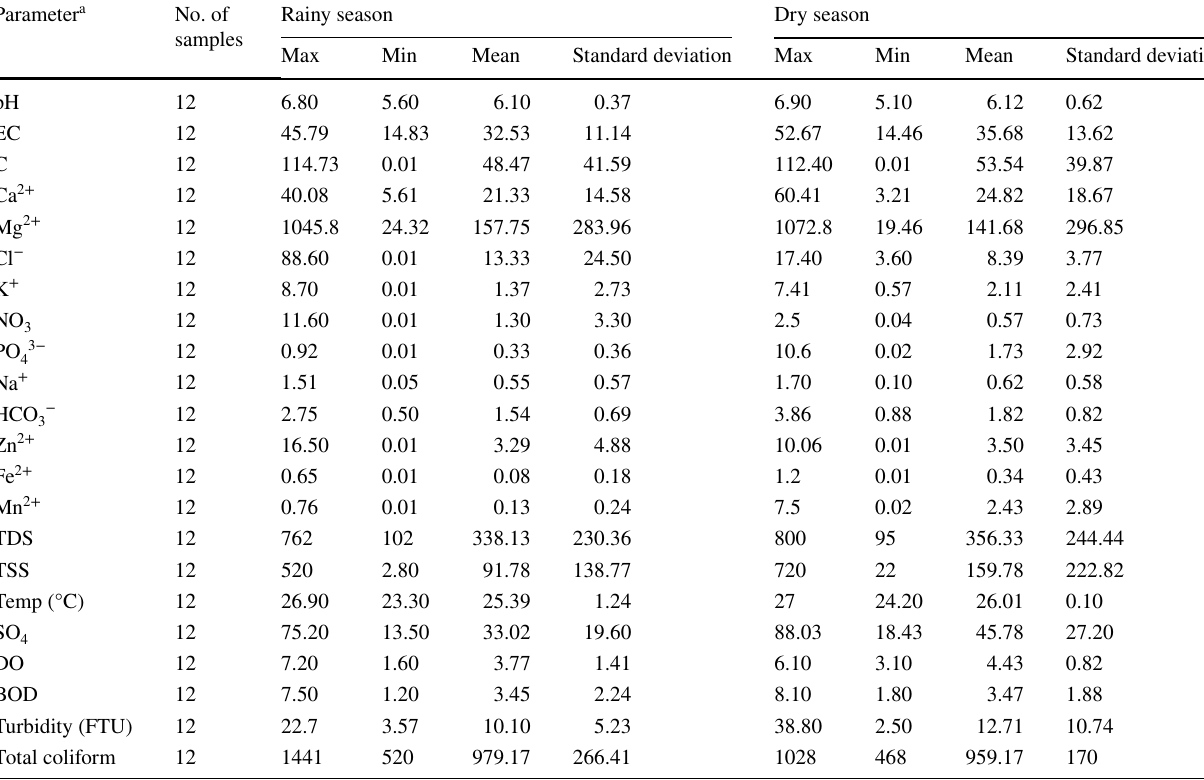
Table 7 Descriptive statistics of the analyzed hydro-geochemical properties Parameter a